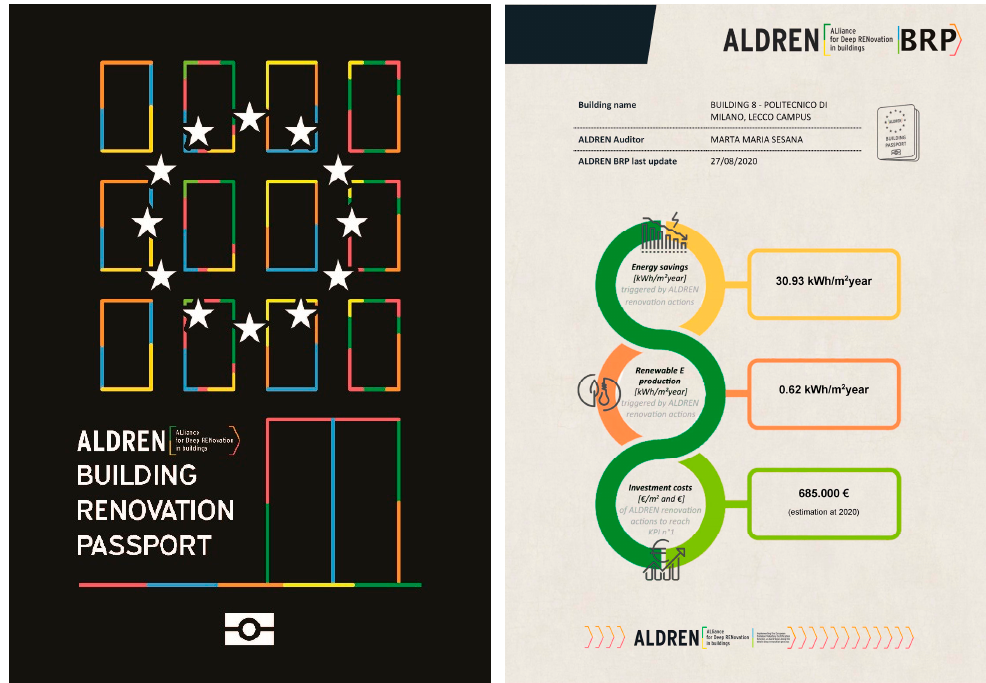
Figure 5. Cover and KPIs page of the ALDREN BRP Paper version for Building 8, Politecnico di Milano—Lecco Campus.